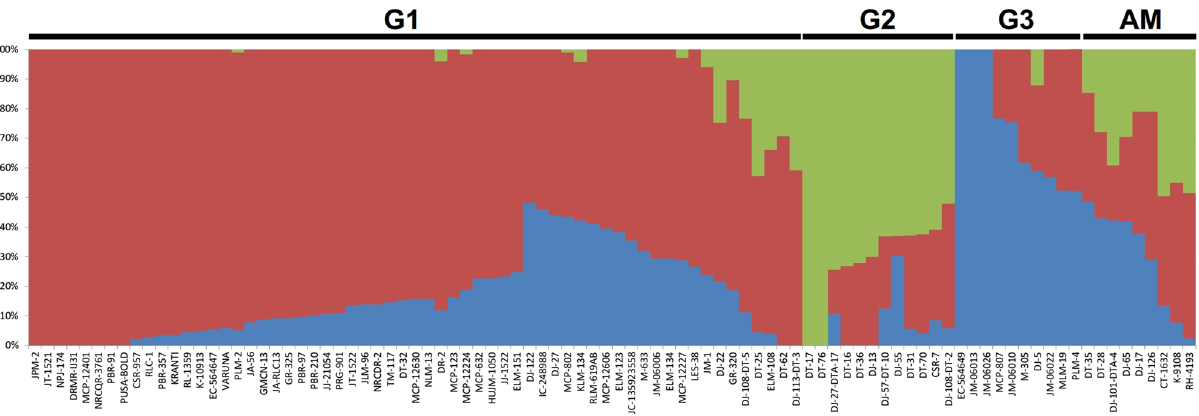
Figure 1. Population structure analysis suggesting three population groups in Brassica juncea association panel at ΔK = 3. Group 1 primarily included mustard varieties grown in India, while all resynthesized B. juncea